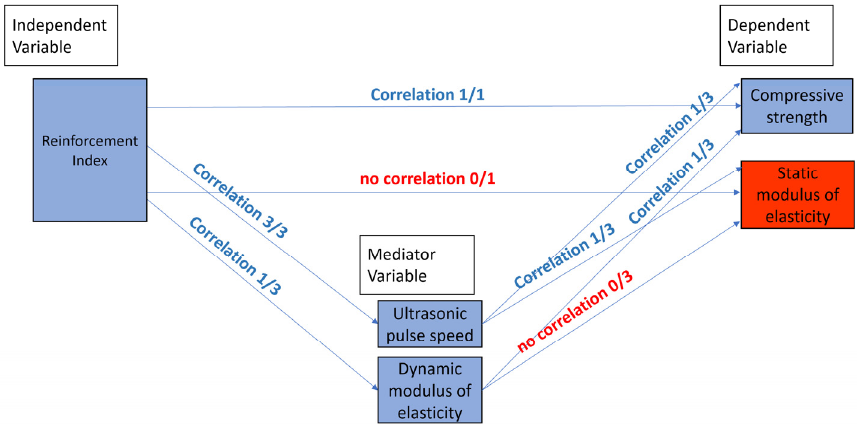
Figure 18. Correlations between experimental design variables.